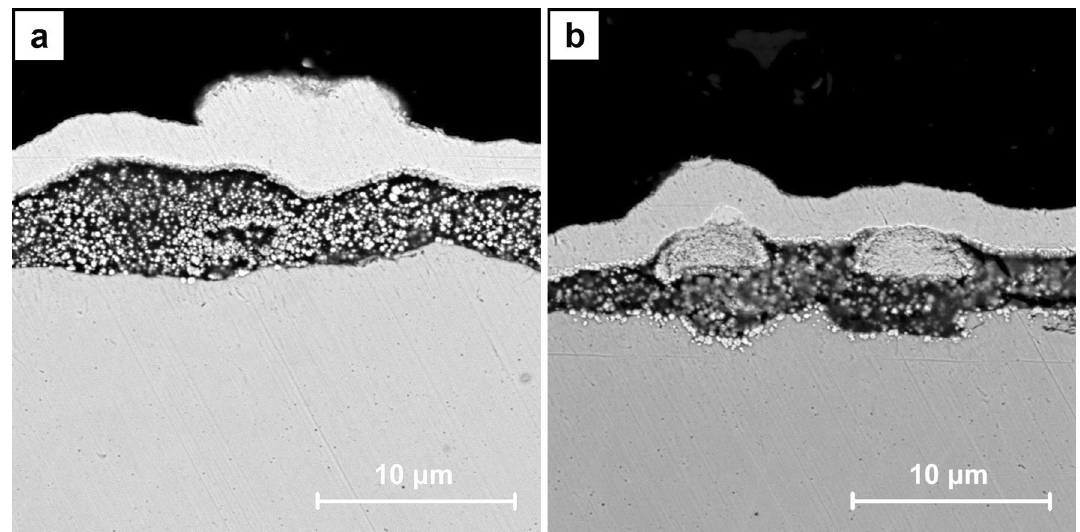
Figure 13. SEM images of the cross sections of B7 sample (ECD deposition time of 600 s, CuSO 4 concentration of 100 mM) at the magnification of